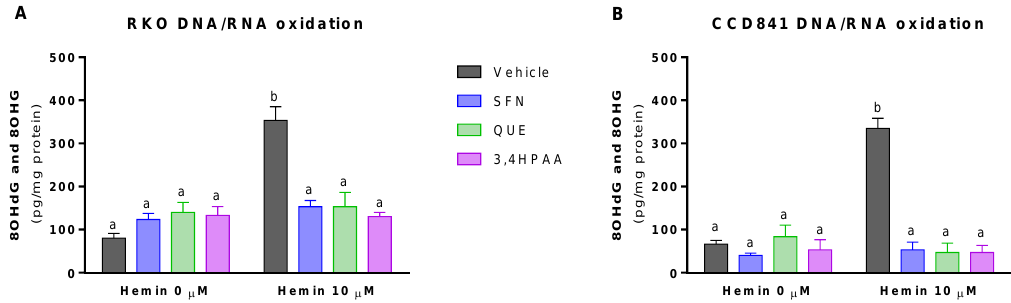
Figure 4. Effect of hemin, SFN, QUE and 3,4HPAA in DNA/RNA damage. Cells were incubated with vehicle (0.4% DMSO), 1 μM SFN, 10 μM QUE or 2.6 μM 3,4HPAA in the absence or presence of 10 μM hemin. After 72 h, 8OHdG and 8OHG levels were assessed in ( A ) RKO; and ( B ) CCD841 cell supernatants. The results were expressed as pg (8OHdG and 8OHG)/mg of protein. Values are expressed as mean ± SEM, from three independent culture preparations. For all bars with the same letter, the difference between the means is not statistically significant. Values with different letters indicate significant differences ( p < 0.05) between bars (two-way ANOVA, Bonferroni post-test). 3,4HPAA, 3,4-dihydroxyphenylacetic acid; 8OHdG, 8-hydroxy-2′-deoxyguanosine; 8OHG, 8- hydroxyguanosine; QUE, quercetin; SFN, sulforaphane.